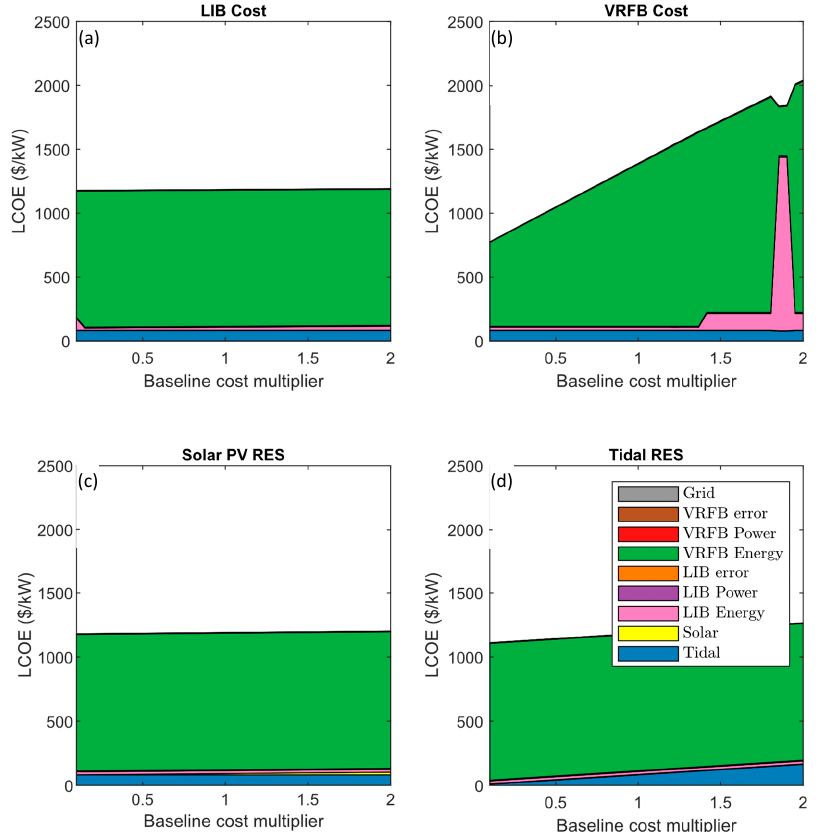
Figure 6. Results of the cost parametric study where each component cost varies from 1/10th the baseline to 2 times the baseline. Subplot ( a ) shows the LIB energy capacity cost variation. Subplot ( b ) shows the VRFB module cost variation coming primarily from the cost of the electrolyte, mem- brane, and electrodes. Subplot ( c ) shows the Solar PV RES rated power cost variation. Subplot ( d ) shows the Tidal RES rated power cost variation. Note: Nearly all of the LCOE is a result of the VRFB Energy, Tidal, and LIB Energy system components. Other system components are included in these calculations but account for smaller LCOE that is not visible in the graphs.